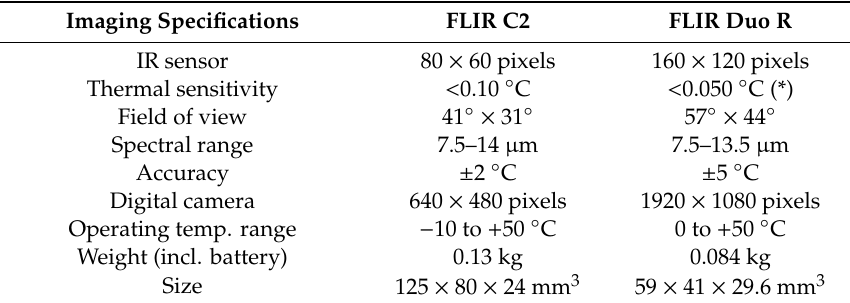
Table 2. Comparison of selected recording devices.